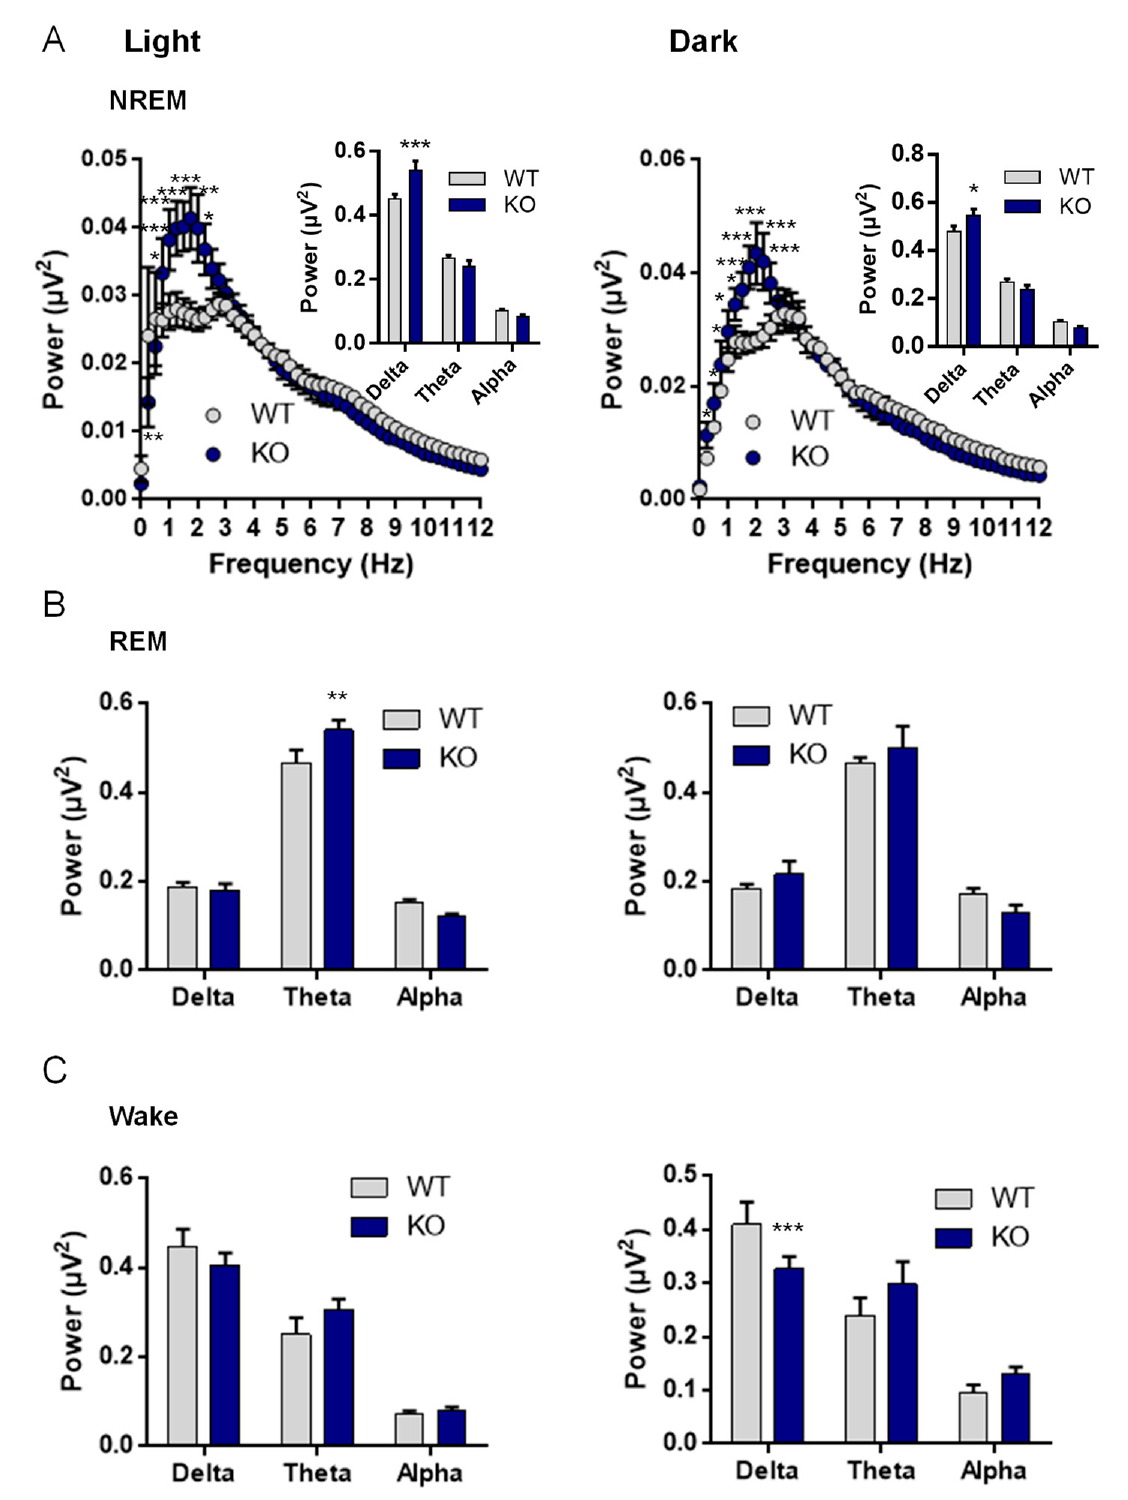
Figure 7. Sleep recording analysis in VMAT2 DBHcre mice: power spectrum frequency. ( A ) Average spectral distribution of cortical EEG power spectrum during NREM in WT (n = 6) and KO (n = 4) VMAT2 DBHcre mice during the light cycle (left; genotype: F (1,384) = 13.59, p = 0.006; frequency: F (48,384) = 37.49, p < 0.001; genotype × frequency: F (48,384) = 2.50, p < 0.001; post-hoc test * p < 0.05, ** p < 0.01, *** p < 0.001) and the dark cycle (right; genotype: F (1,384) = 8.15, p = 0.021; state : F (48,384) = 77.11, p < 0.001; genotype × state: F (48,384) = 3.64, p < 0.001; post-hoc test * p < 0.05, ** p < 0.01, *** p < 0.001). The power analysis by frequency ranges (delta: 0.5–4.5 Hz; theta: 5–9 Hz; alpha: 9–12 Hz) is shown in the top right corner of each NREM power spectrum distribution curve during the light cycle (top; genotype: F (1,24) = 1.39, p = 0.25; state: F (2,24) = 360.19, p < 0.001; genotype × state: F (2,24) = 9.31, p = 0.001; post-hoc test *** p < 0.00032) and the dark cycle (bottom; genotype: F (1,24) = 0.052, p = 0.82; state: F (2,24) = 280.88, p < 0.001; genotype × state: F (2,24) = 4.70, p = 0.019; post-hoc test * p < 0.015). ( B ) Wake period power spectrum analysis by frequency ranges (delta: 0.5–4.5 Hz; theta: 5–9 Hz; alpha: 9–12 Hz) in WT (n = 6) and KO (n = 4) VMAT2 DBHcre mice during the light cycle (left; genotype: F (1,24) = 0.091, p = 0.76; frequency: F (2,24) = 67.79, p < 0.001; genotype × frequency: F (2,24) = 1.28, p = 0.30) and the dark cycle (right; genotype: F (1,24) = 0.74, p = 0.40; frequency: F (2,24) = 57.88, p < 0.001; genotype × frequency: F (2,24) = 9.20, p = 0.0011; post-hoc test *** p = 0.00055). ( C ) REM period power spectrum analysis by fre- quency ranges (delta: 0.5–4.5 Hz; theta: 5–9 Hz; alpha: 9–12 Hz) in WT (n = 6) and KO (n = 4)